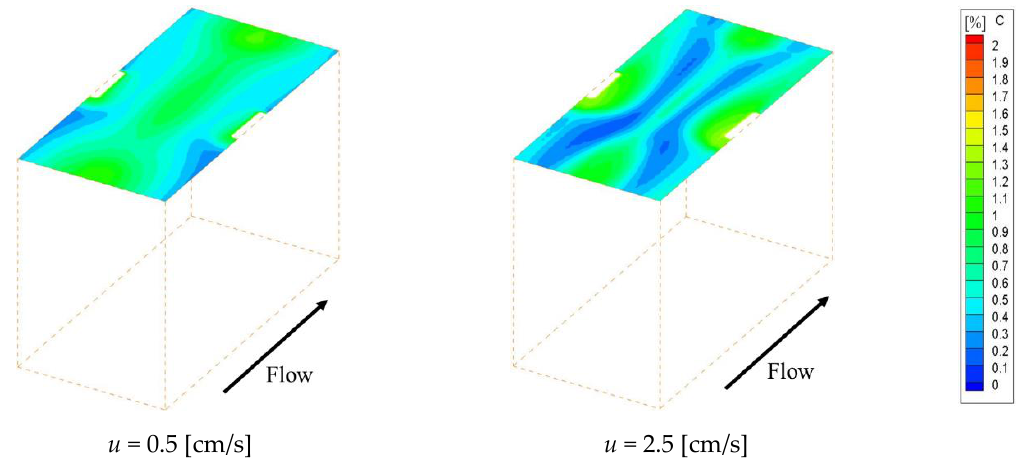
Figure 10. Concentration distribution when using Spacer 4. The spacer 4 can solve the problem that the low concentration region is formed due to the flow stagnation behind the structure.